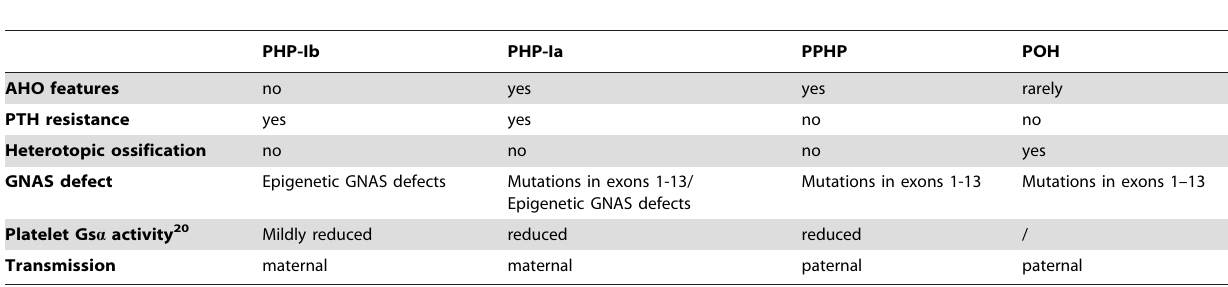
Table 1. Phenotypic, Molecular Genetic and Platelet Gs protein activity in relation to GNAS